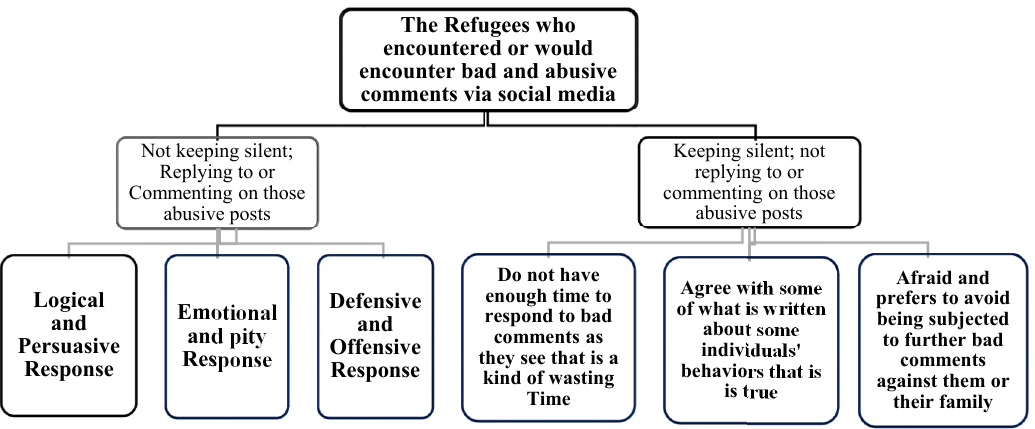
Figure 2. The defense mechanisms of the participants against the hate speech towards them on social media .